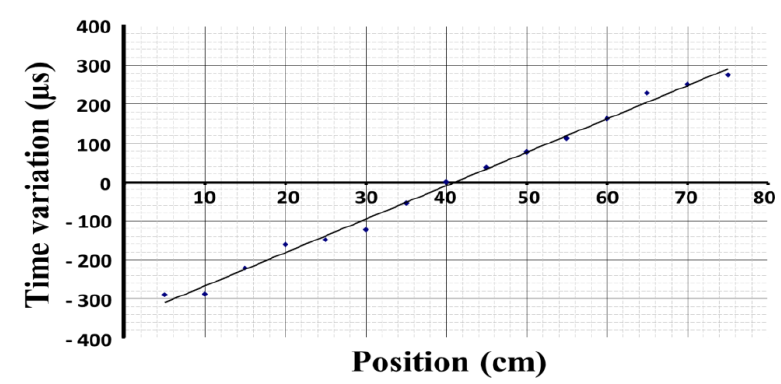
Figure 6. Calibration curve for an 80 cm